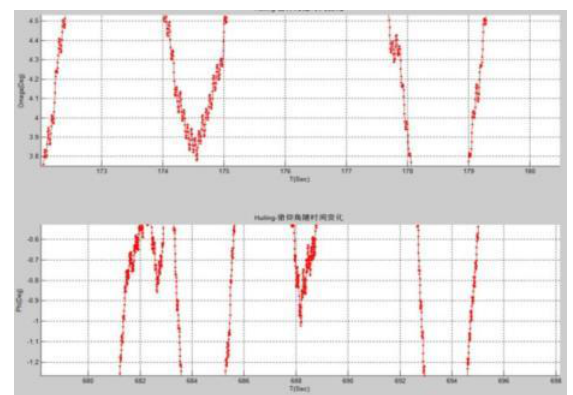
Figure 24 INS data on Omiga and Phi axis of turbine-shaft helicopter INS has limited measurement capacity. IMU of the LIDAR system features a 200Hz sampling rate and a ± 0.0025 degree drift in angular accuracy. Therefore, it is impossible for a gasoline helicopter platform with high vibration intensity and wide distribution of vibration frequency to have only two